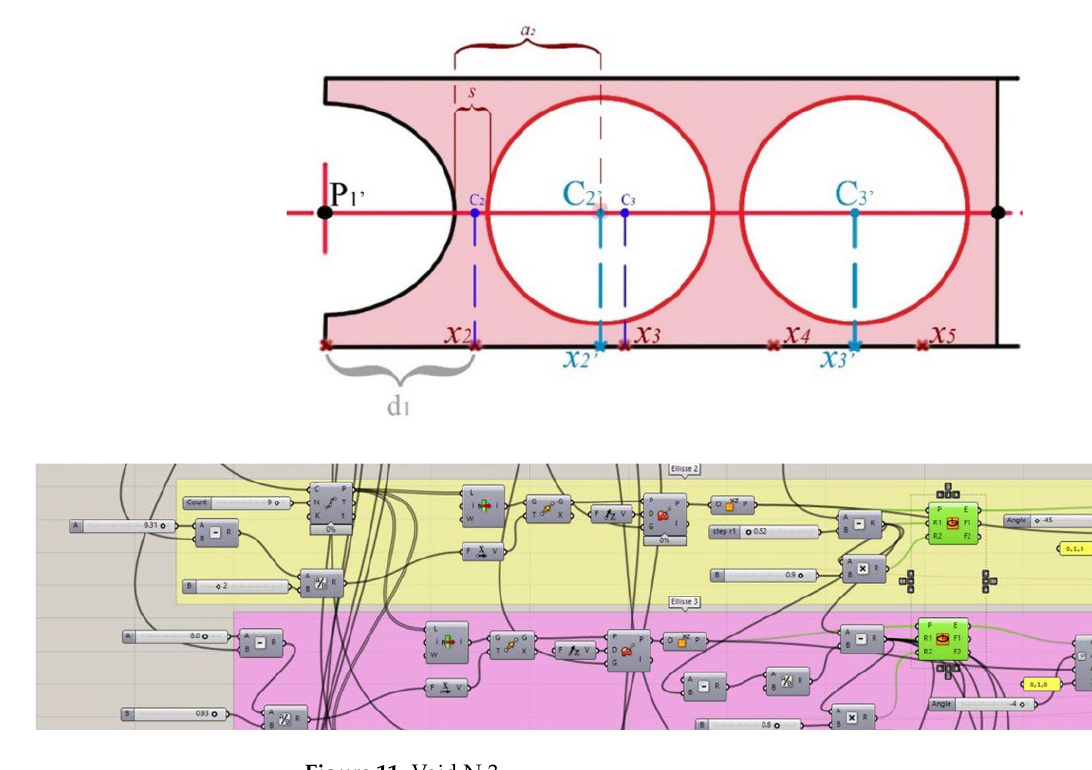
Figure 11. Void N.3.